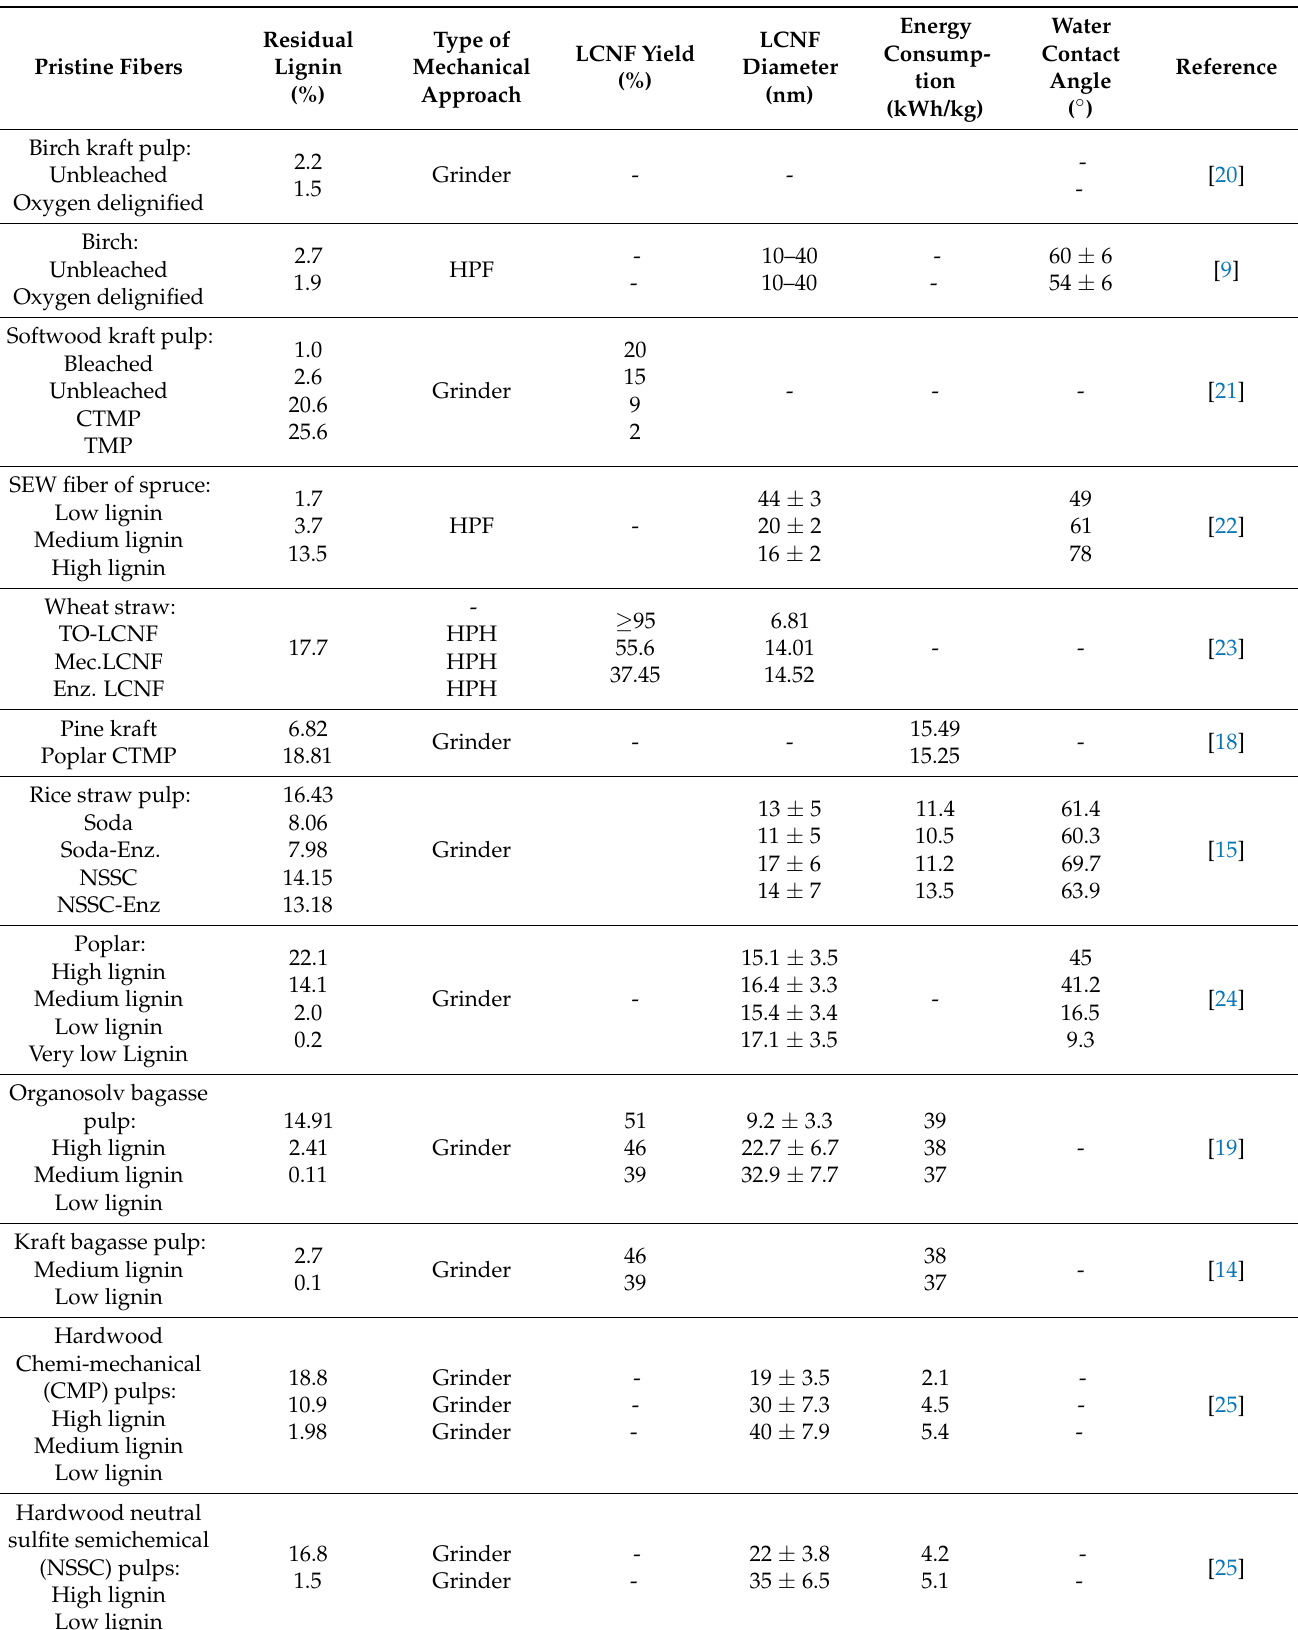
Table 2. Important characteristics of LCNFs prepared from different pristine cellulose